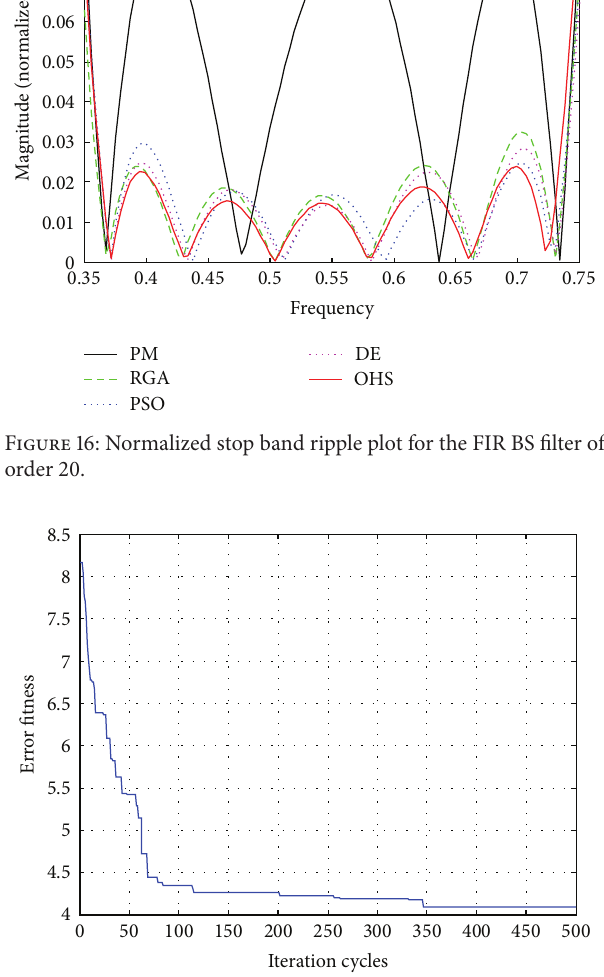
Figure 17: Convergence profile for RGA in case of FIR HP filter of order